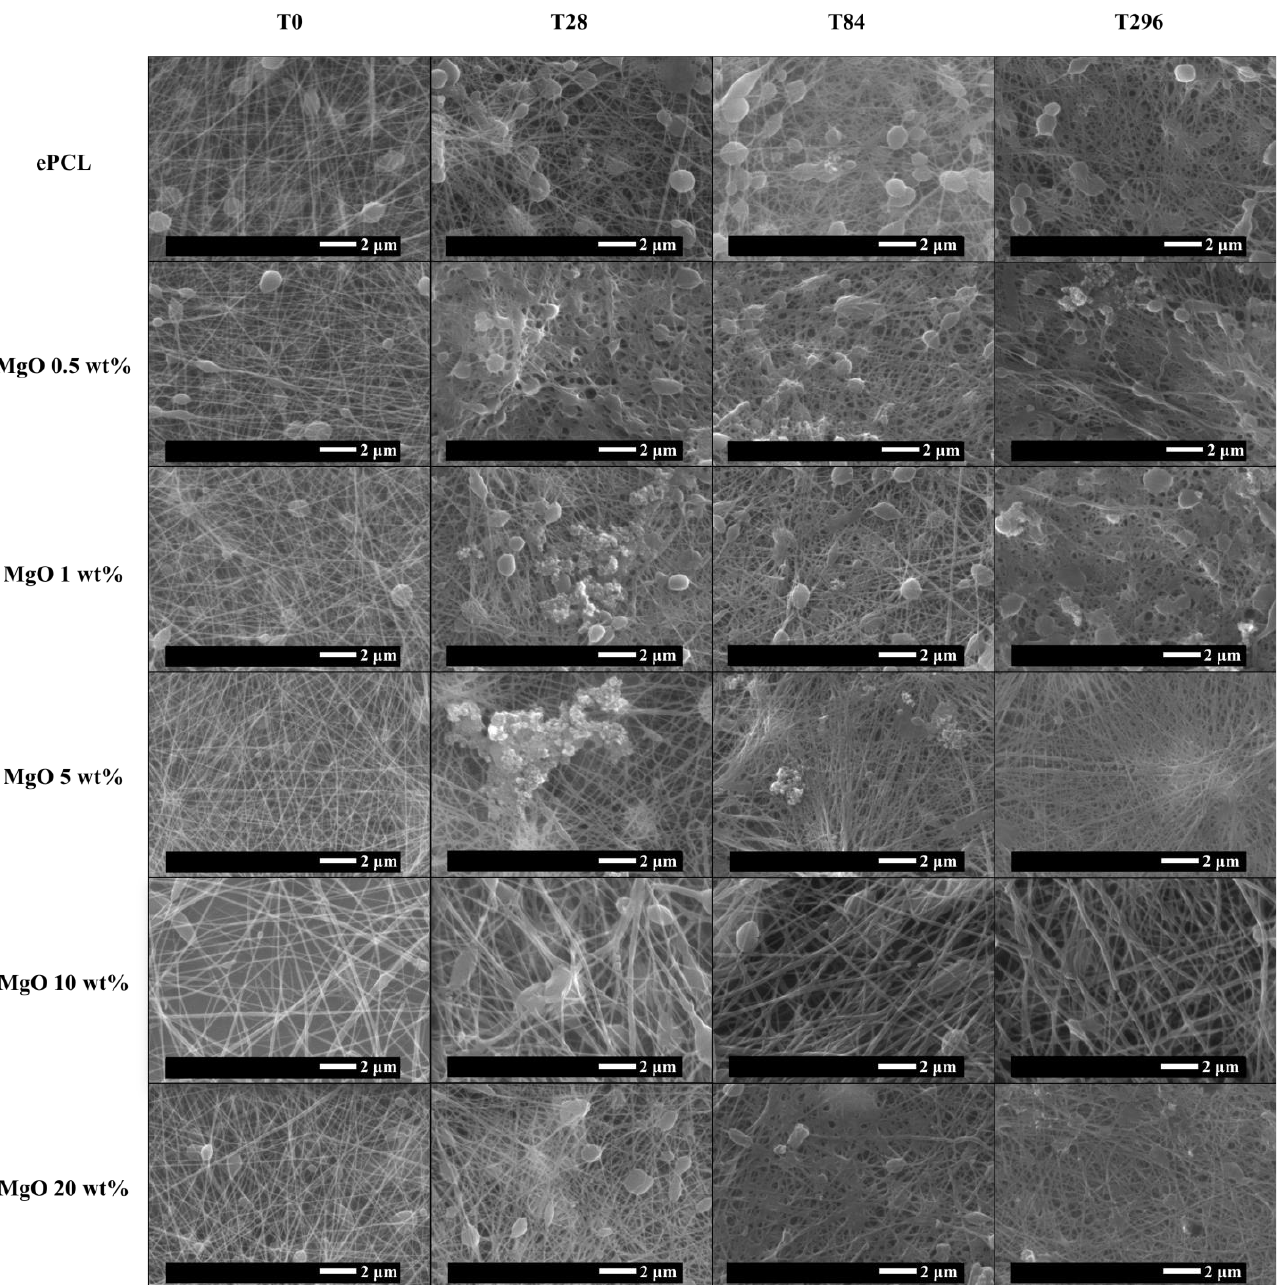
Figure 3. SEM images of ePCL and ePCL + MgO NPs at T0, T28, T84 and T296 in PBS .